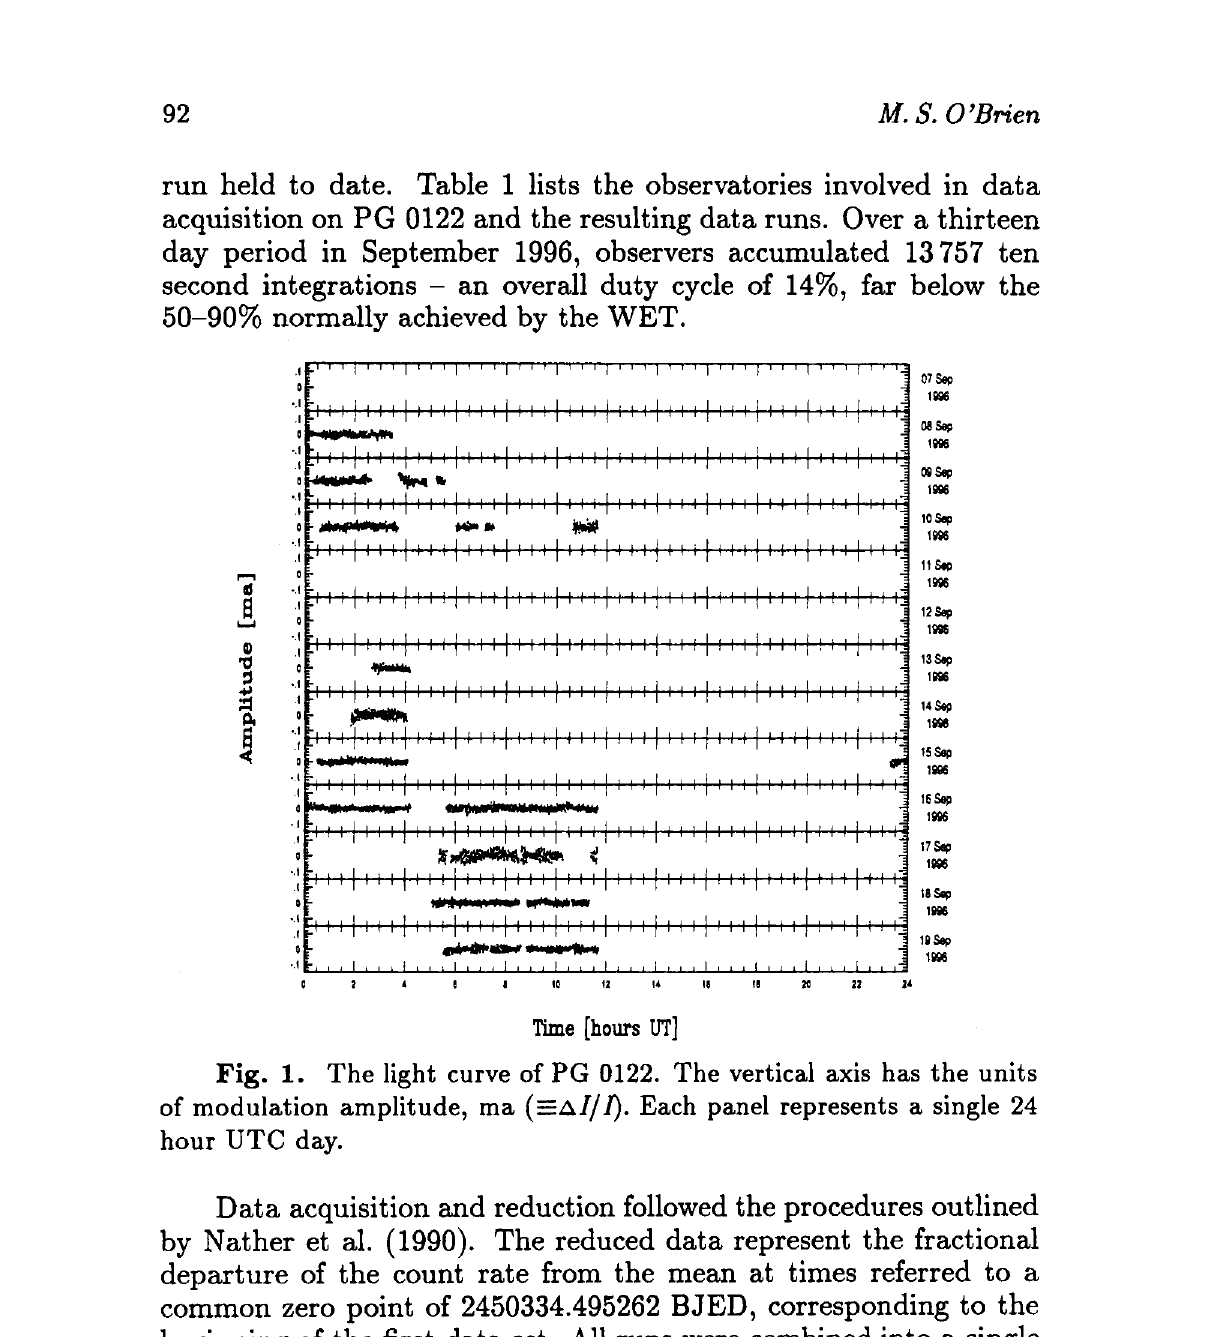
Fig. 1. The light curve of PG 0122. The vertical axis has the units of modulation amplitude, ma (=A///). Each panel represents a single 24 hour UTC